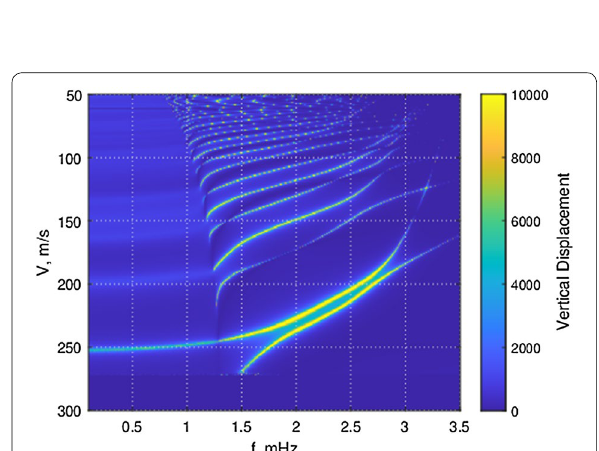
Fig. 6 Full-wave simulations of the oscillations in the thermosphere due to ground-level vibrations. Oscillations are generated by monochromatic vertical displacements of frequency f traveling with the subsonic velocity V along the lower boundary of the atmosphere. Color shows the amplitude of the vertical displacement at z 180 km. The displacement amplitudes are normalized by their = values at z 0 and are dimensionless. The simulation assumes the = same winter atmospheric conditions over Wallops Island (Virginia, USA) and propagation direction of the excitation as in Fig.